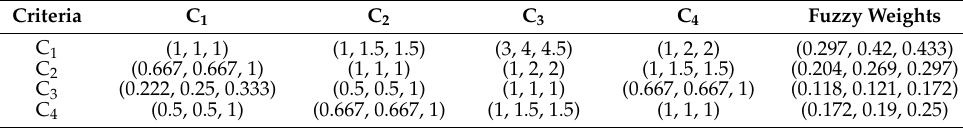
Table 6. Pairwise comparison matrix of four criteria with respect to each other.